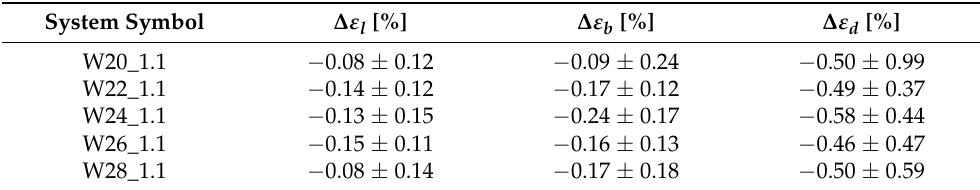
Table 4. The dimensional stability of the bio-foams measured at 70 °C after 24 h.